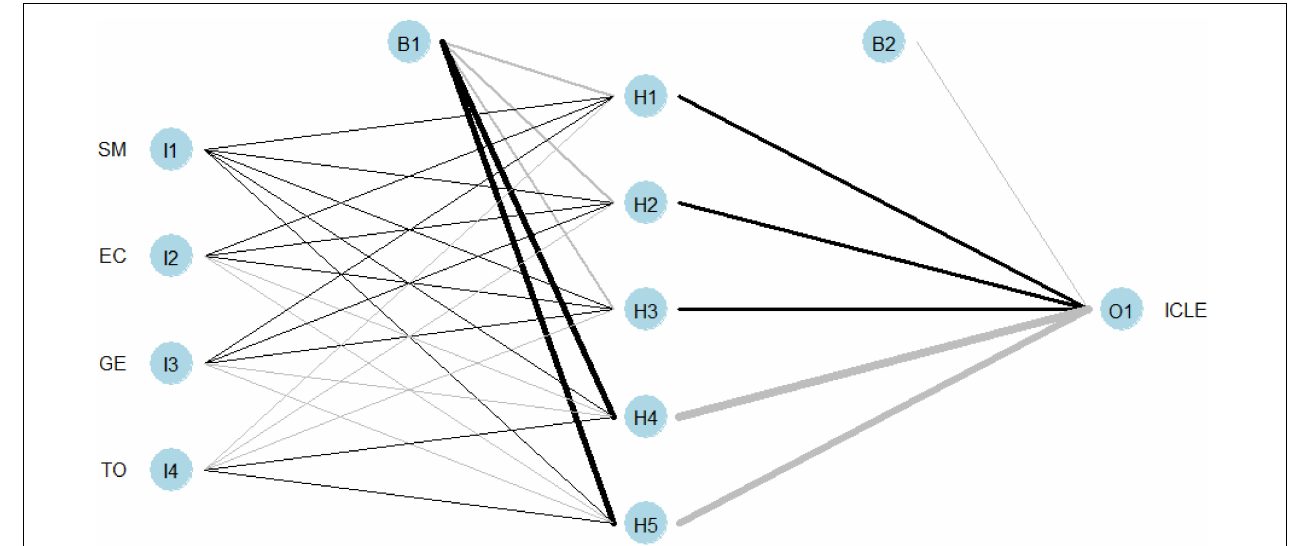
FIGURE 2 | Calculation